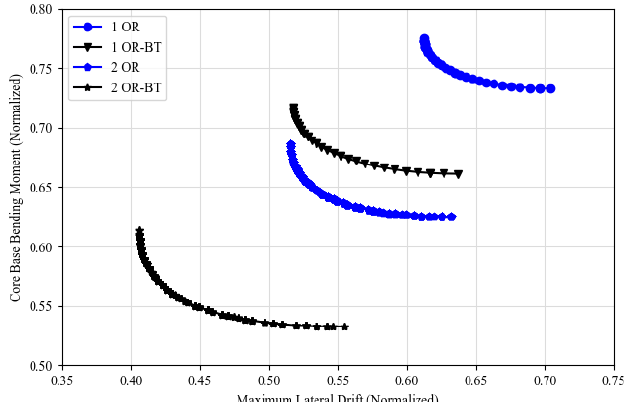
Figure 13. Pareto frontier for 1 and 2 ORs/ORs-BTs